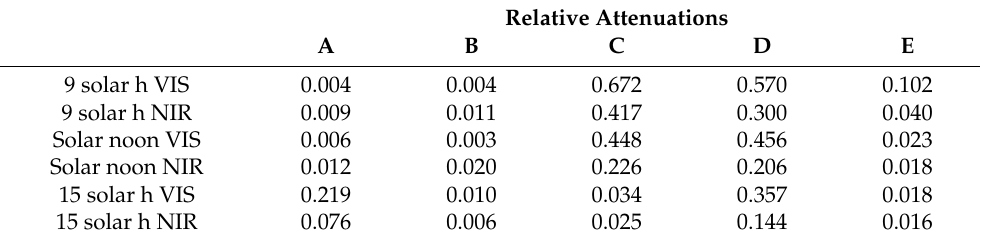
Table 5. Mean relative attenuation values for the VIS and NIR bands in summer and at 3 times of day.